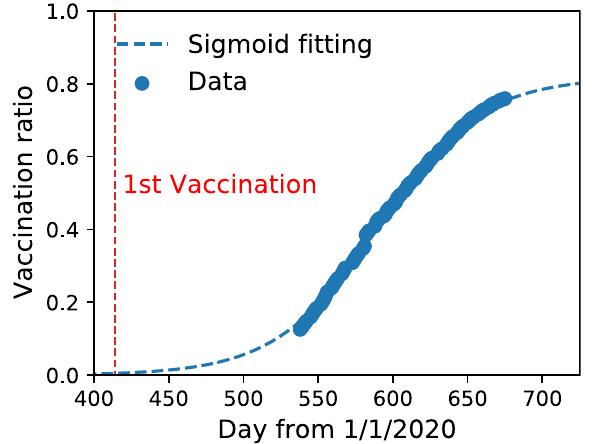
Figure 4. Vaccination ratio of the population of Japan calculated as R V ( t ) = (number of vaccinations in Japan up to date t )/2(Japanese population). The first vaccination day is shown. A sigmoid-like function R ∞ S (γ V ( t − t V )) fits the data, and the parameters are t V = 590 , γ − 1 V